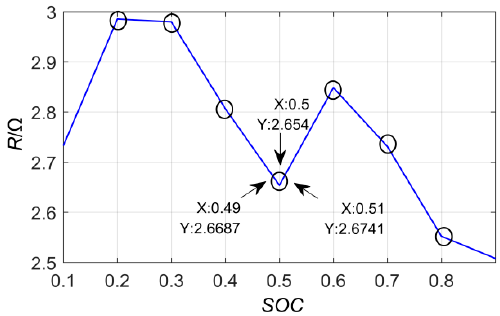
Figure 9. Original data curve.